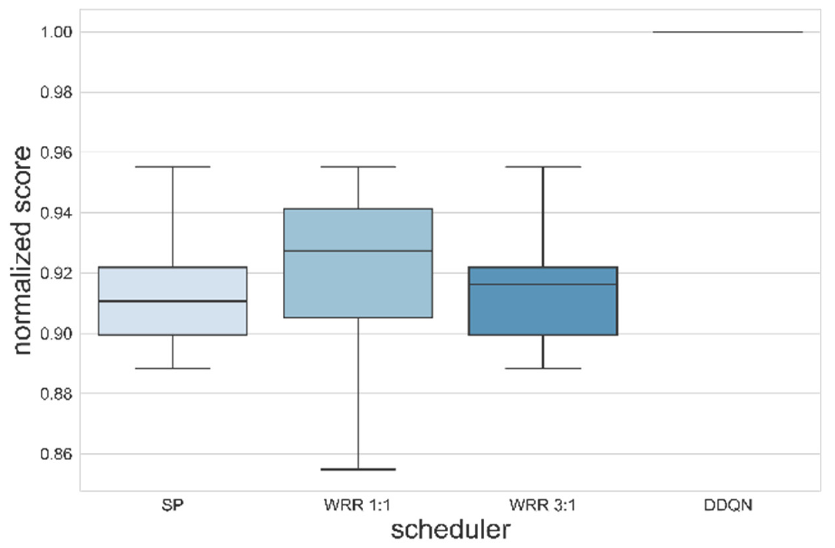
Figure 8. Boxplot comparing the scores of schedulers. The DDQN, after learning, achieved perfor- mance of a normalized score close to 100% even though parameters were changed, proving that it would adapt well to dynamic environments. Table 6. WRR results according to different weights in single node simulation.